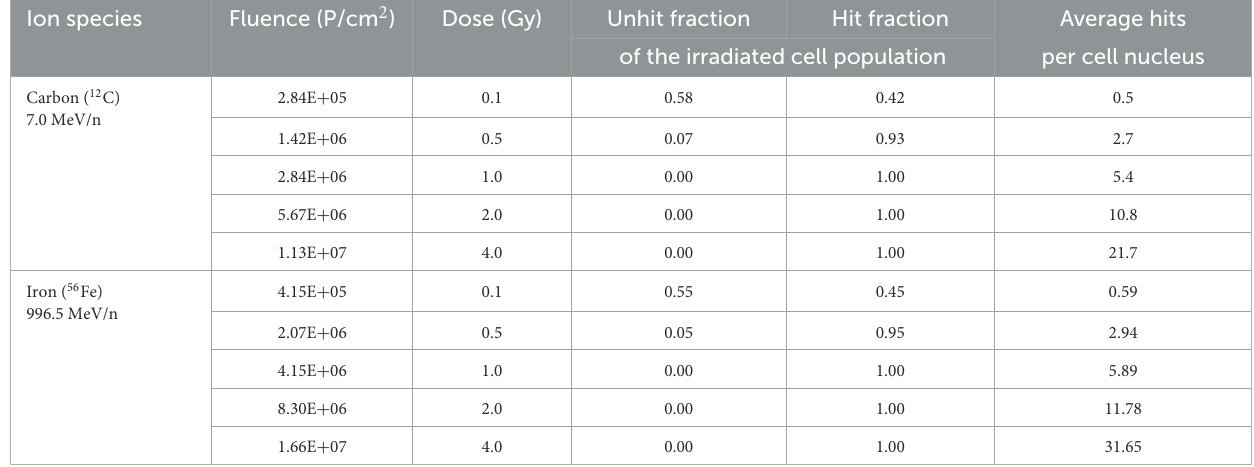
TABLE 3 Hit calculation for carbon and iron ions exposure of primary murine astrocytes. Ion species Fluence (P/cm 2 ) Dose (Gy) Unhit fraction Hit fraction Average hits of the irradiated cell population per cell nucleus Carbon ( 12 C) 2.84E + 7.0 MeV/n